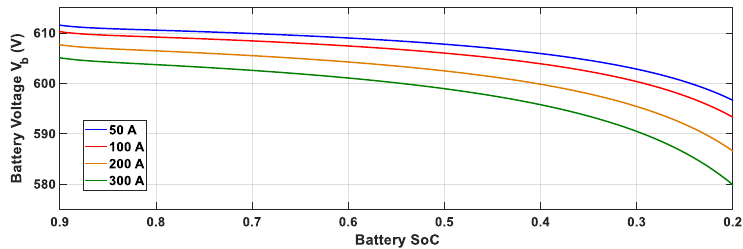
Figure 16. Battery voltage vs. state of charge (SoC) for different loading conditions.